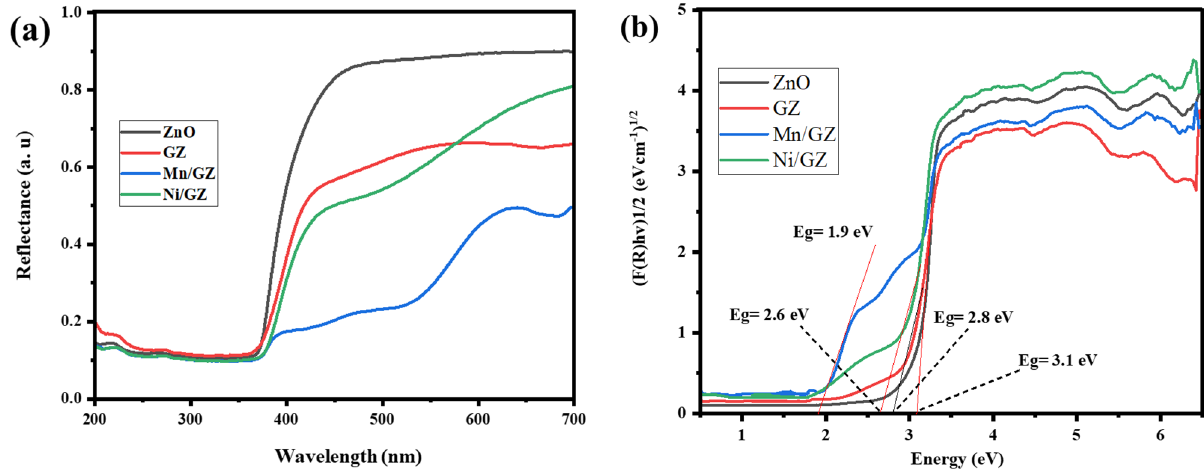
Figure 7. UV-vis DRS spectra ( a ) and band gap energy of ZnO, GZ, Mn/GZ, and Ni/GZ NCs ( b ).